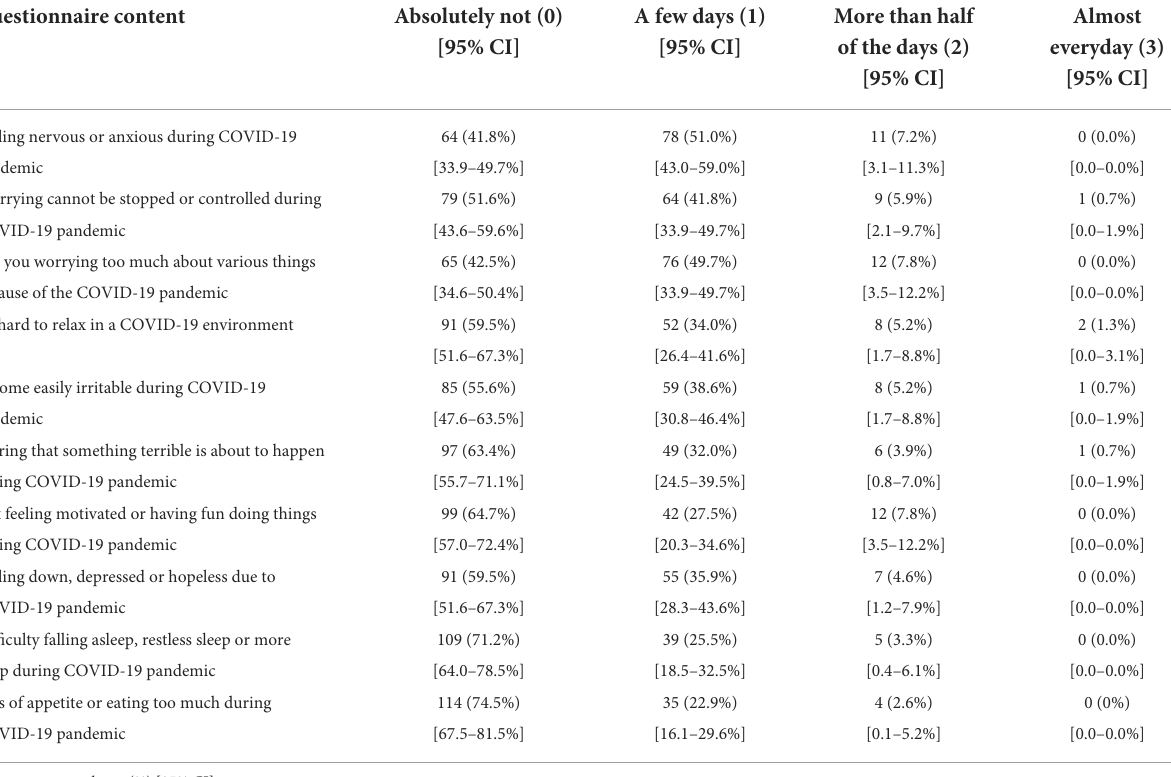
TABLE 2 The impact of the COVID-19 pandemic on mental health of medical graduate studies.